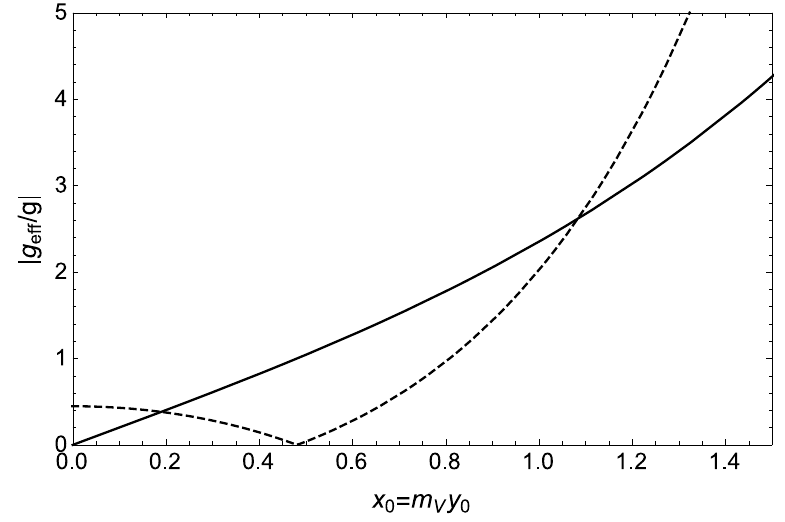
Figure 2 . Magnitude of e(cid:11)ective gauge coupling for the 1st KK (solid line) and the 2nd KK (dashed line) modes as a function of fermion localization position. Here, we have taken (cid:15) = 1.